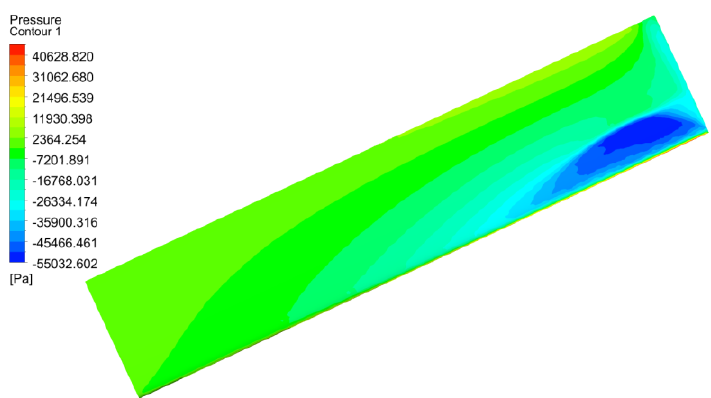
Figure 3. Pressure contours of a blade in working condition 3.